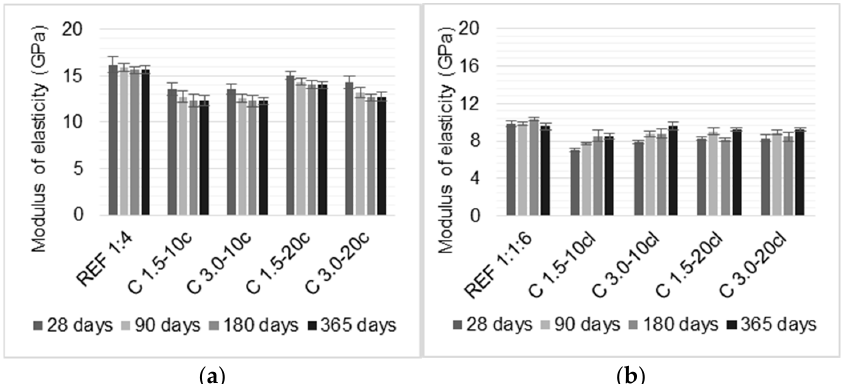
Figure 6. Dynamic modulus of elasticity of the: ( a ) cement mortars and ( b ) cement-lime mortars.